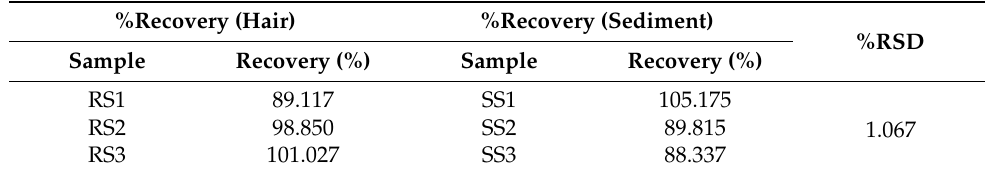
Table 5. Precision values of arsenic metal and %Recovery for hair and sediment samples.